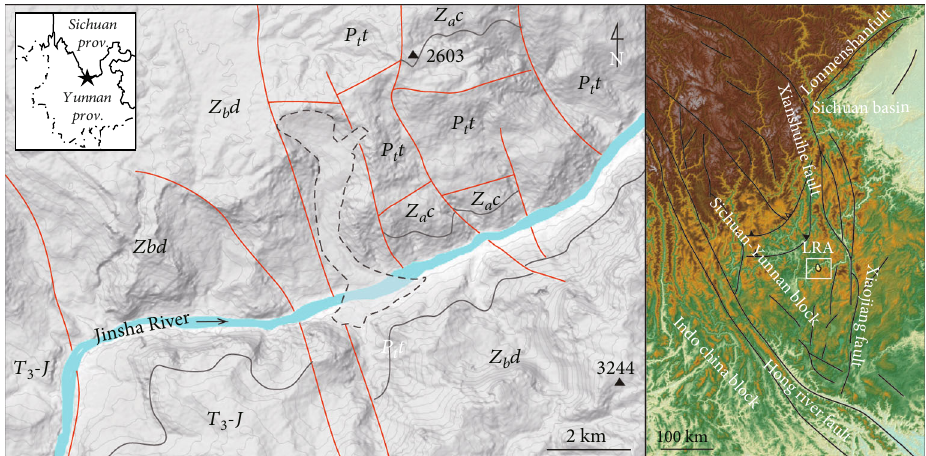
Figure 1: Geographical location and geological background of LRA.